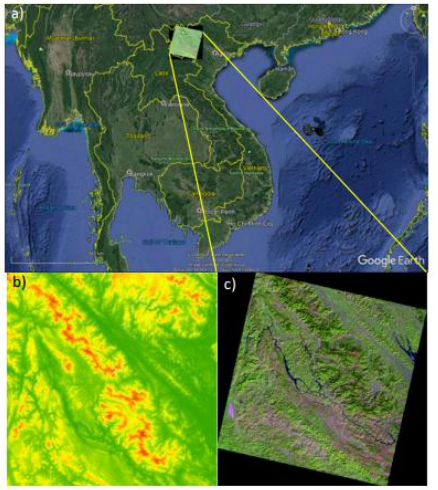
Figure 1. Study area; a) Location of study site in Vietnam; b) Digital elevation model; c) False colour composite of Landsat 8 RGB:654 of Dec. 20, 2017. Table 1. List of fifty Landsat scenes used to generate bimonthly cloud free land covers of 2017 All downloaded Landsat scenes are of level-1 processing and before classification of land cover, digital number DN was converted to top of atmosphere (TOA) reflectance. Figure 2 show example of complexity of cloud cover of the study area during January and February of year 2017. This complexity explains reason for usage of more Landsat scenes to compensate cloud pixels to achieve cloud free land